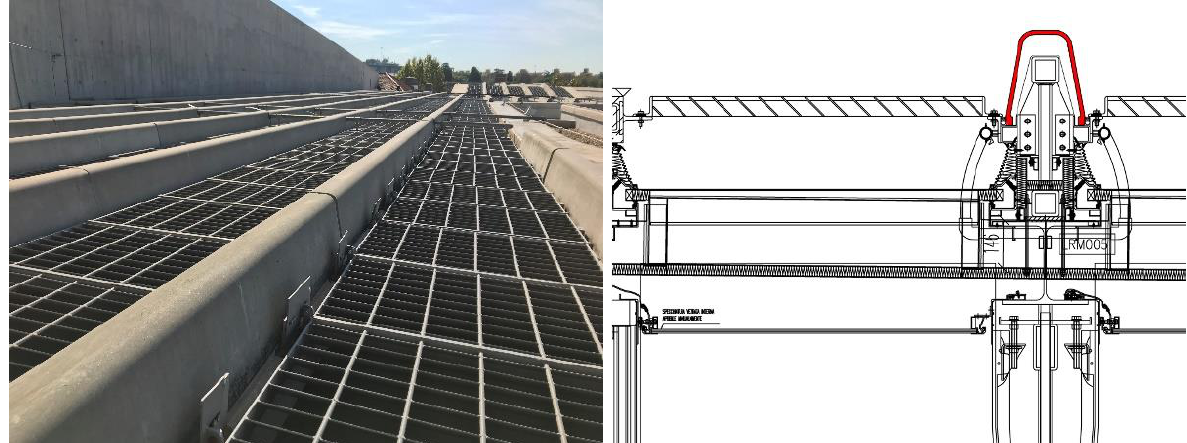
Figure 10. MAXXI, Rome (2010). The glass-fibered reinforced concrete caps shown in a picture taken on the roof (ph. Cardellicchio, 2018) and on the construction detail (courtesy: MAXXI).